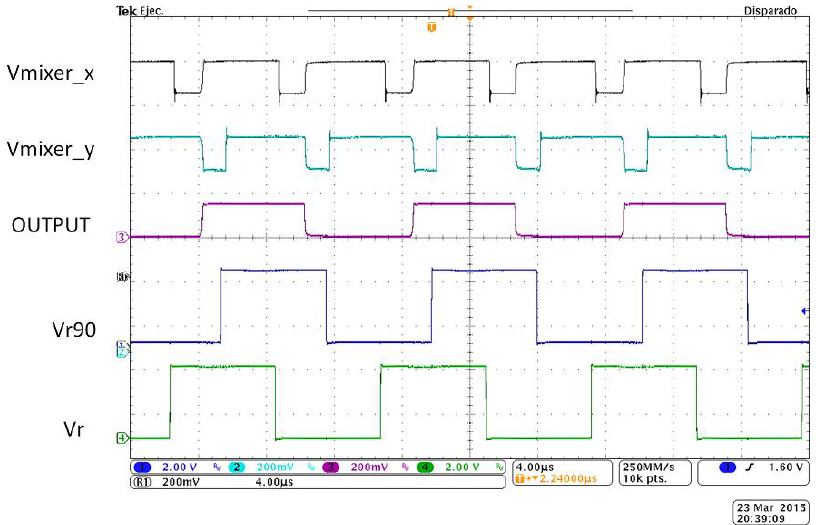
Figure 7. LIA signals for an input signal of 150 mV rms at an operating frequency of 80 kHz. Square quadrature signals V r , (green), V r 90 (blue), sensor signal OUTPUT (purple) and